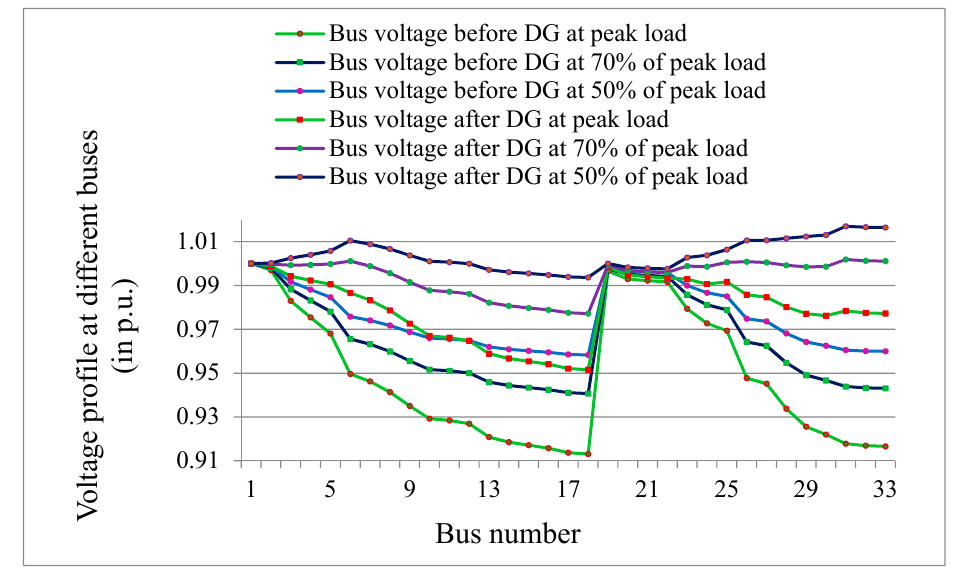
Figure 18. Bus voltage for IEEE 33-bus system for various load levels before and after DG placement at different bus.